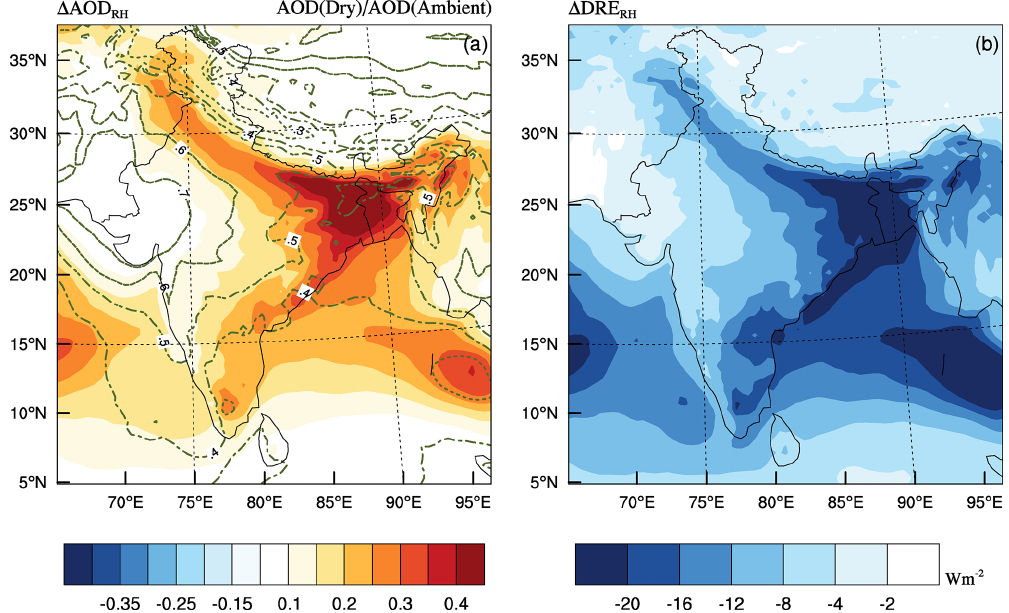
Figure 4. (a) Aerosol optical depth (AOD) simulated using RegCM4 for dry and ambient humidity conditions. Colour map indicates AOD(ambient) – AOD(dry) for simulations without meteorological feedback, and line contours show AOD(dry) / AOD(ambient). (b) Dif- ference in aerosol direct radiative effects (DREs) at the surface for dry and ambient humidity conditions (without meteorological feedbacks).